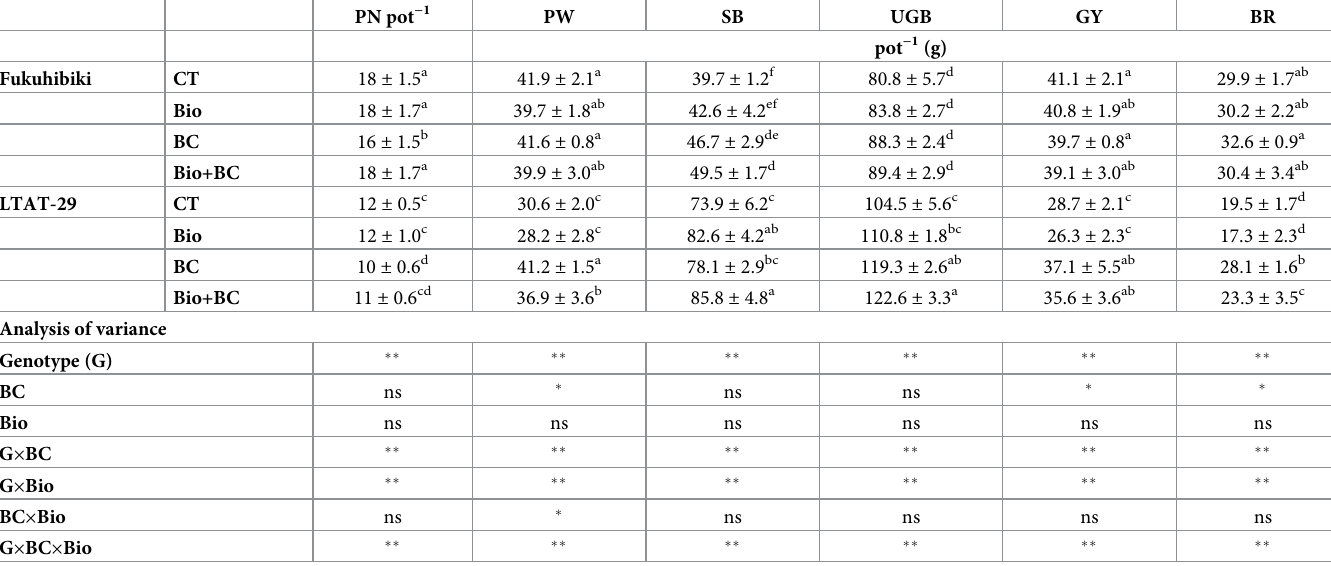
Mean ± SD followed by the same letter are not statistically significant using Fisher’s LSD test (p < 0.05). Note: PN = Panicle number, PW = Panicle weight, SB = Straw biomass, UGB = Upper-ground biomass, GY = Grain yield, BR = Brown rice. � p < 0.05 �� p < 0.01 ns = not significant at 0.05